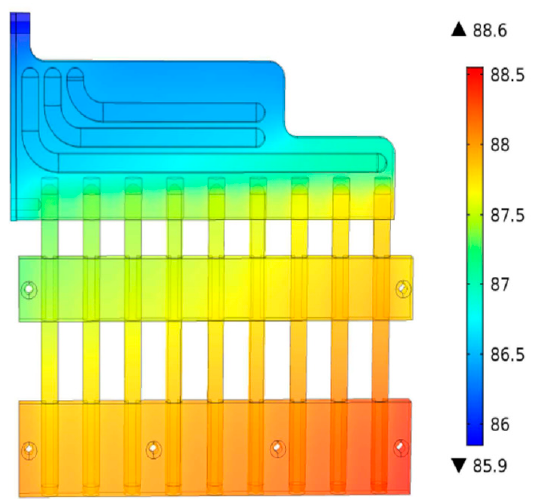
Figure 9. Temperature profile (Type II).